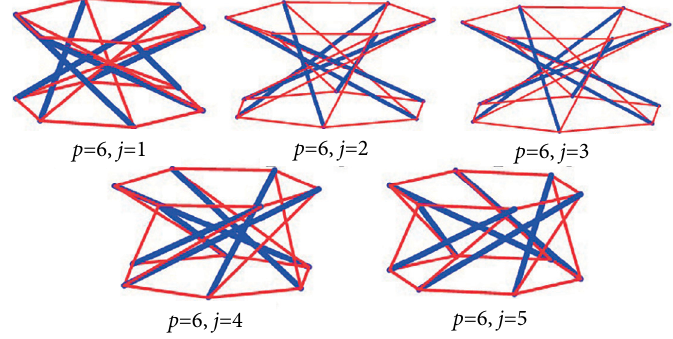
Figure 13. Five configurations of the six-bars tensegrity